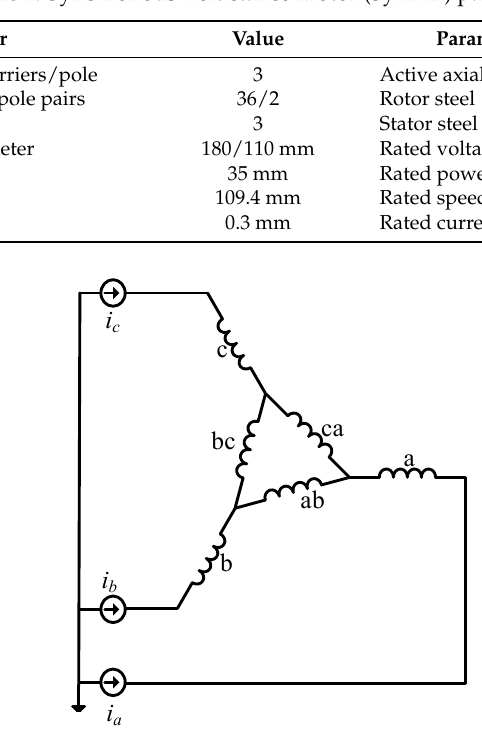
Table 1. Synchronous Reluctance Motor (SynRM) parameters.